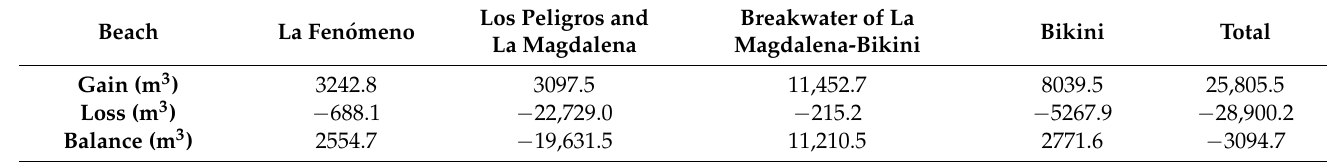
Table 2. Sedimentary balance (m 3 ) between 2010 and 2018, both in November, which indicate that there was a general loss of sand on these beaches